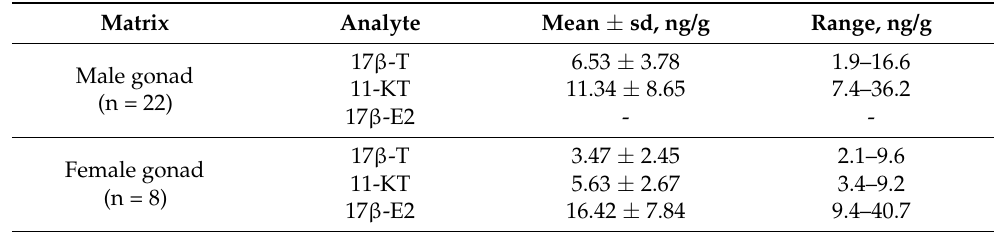
Table 8. Concentrations of 17 β -T, 11-KT and 17 β -E2 (mean ± s.d. and range, ng/g) in the real samples of gonads of sea